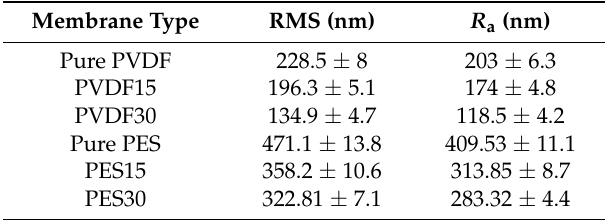
Table 4. Root mean square (RMS) roughness and roughness average ( R a ) of the modified and unmodified membranes surfaces from AFM